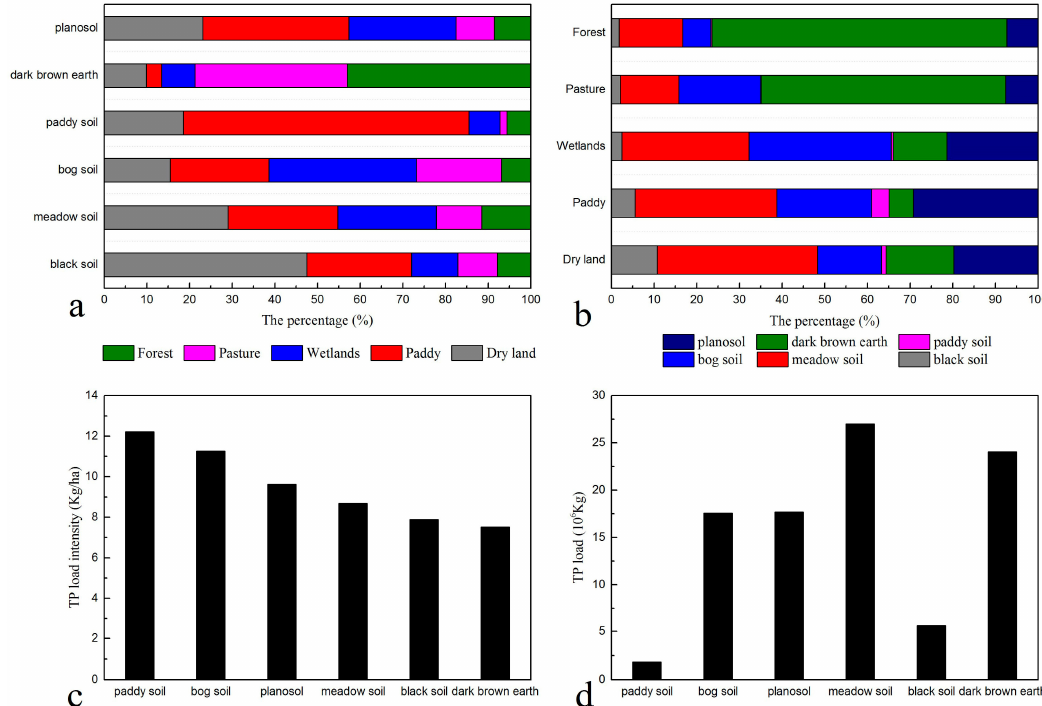
Figure 9. Proportion of soil types in different land use types ( a ); proportion of land use types in different soil types ( b ); load ( c ); and load intensity ( d ) of total phosphorus (TP) for each soil type between 2001 and 2010.